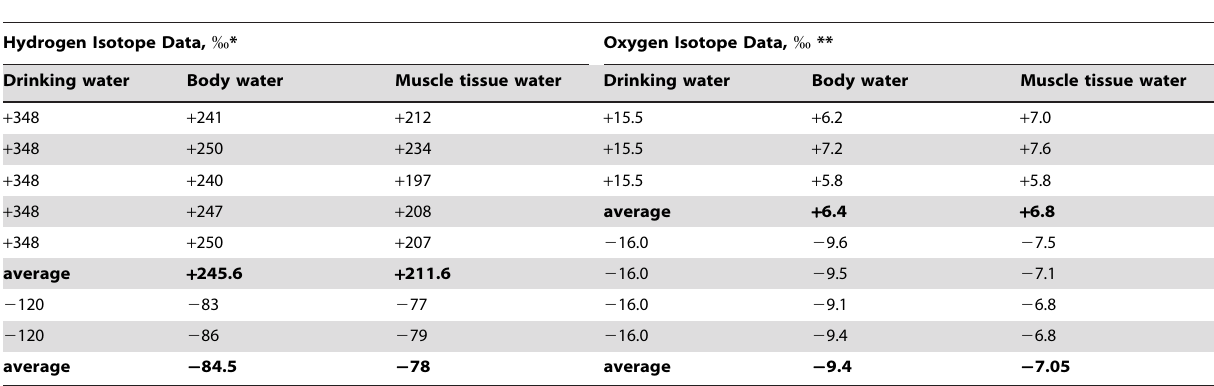
Table 2. d 2 H and d 18 O values of muscle tissue extracted from rats grown on three different waters.